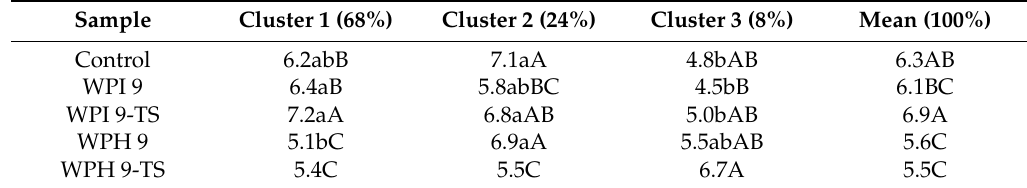
Table 6. Mean ratings of consumers’ liking towards cream cheese. Size of each cluster was indicated (%).